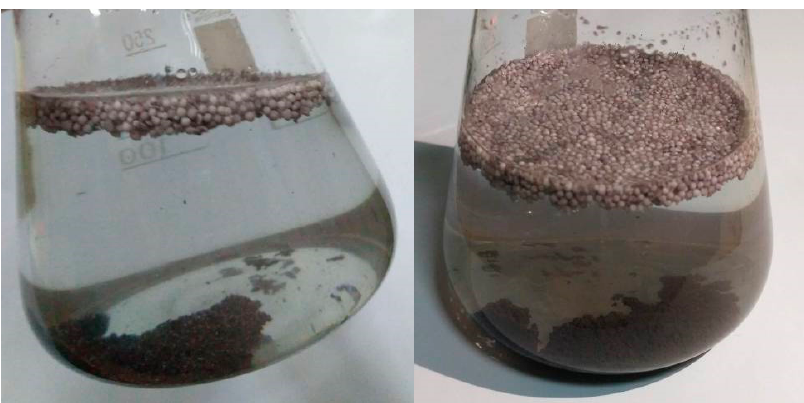
Figure 10. Photograph of the chemical precipitation solution after metallization.